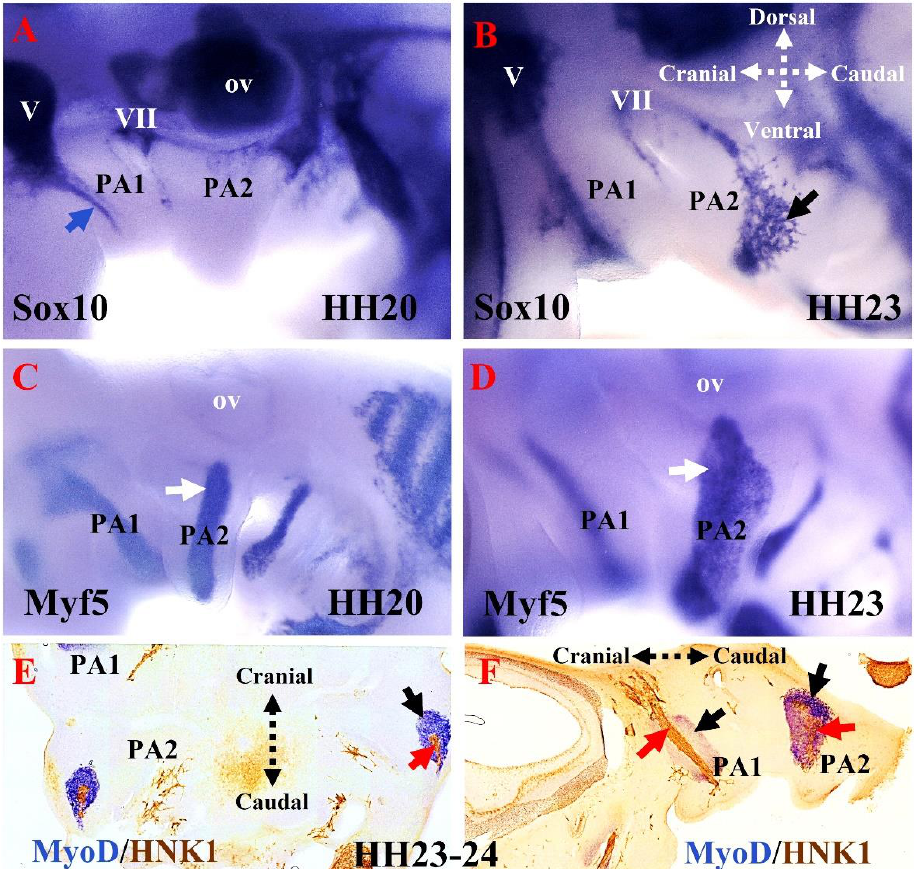
Figure 3. The emergence of the non-ectomesenchymal neural crest in the pharyngeal arches. ( A , B ) Analysis of Sox10 expression in developing chicken embryos using whole-mount in situ hybridization. Lateral views of the left side of chicken embryo stage HH20 and HH23. Sox10 was detected in the otic vesicle, facial ganglion, trigeminal ganglion, and first pharyngeal arch (blue arrow). Sox10 was first detected in the second pharyngeal arch at stage HH23 (facial nerve, black arrow). ( C , D ) Analysis of Myf5 expression using whole-mount in situ hybridization. ( E ) Frontal and sagittal ( F ) sections of a chicken embryo at the level of the second pharyngeal arch were hybridized with the MyoD probe, followed by immunostaining using an HNK1 antibody. Myf5 (white arrows) and MyoD (black arrow) mark the mesodermal core of the pharyngeal arches. In ( E , F ), cranial nerves in the first and second pharyngeal arches are revealed by HNK1 staining (red arrows). PA1, first pharyngeal arch; PA2, second pharyngeal arch; ov, otic vesicle; V, trigeminal ganglion; VII, facial ganglion.